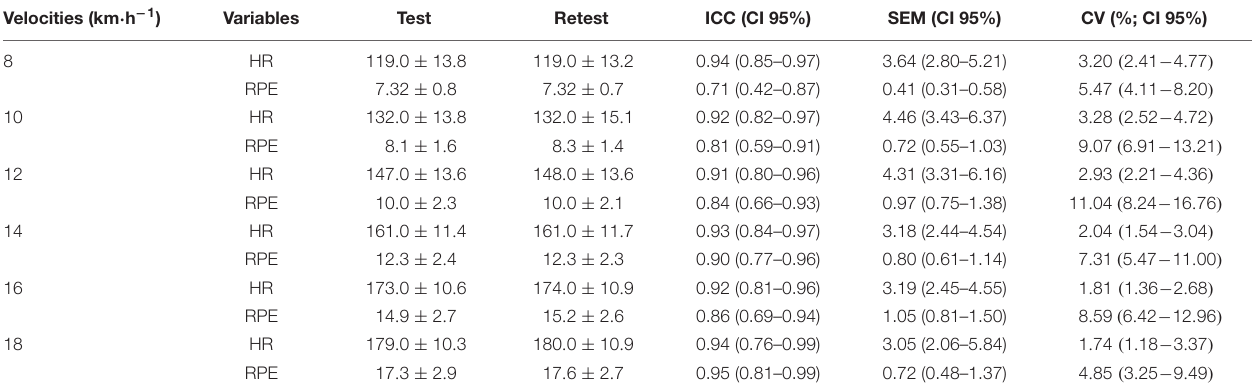
TABLE 4 | Reliability of the submaximal HR and RPE values obtained during the test to V peak _ TF for trained runners (TR). Velocities (km · h − 1 )